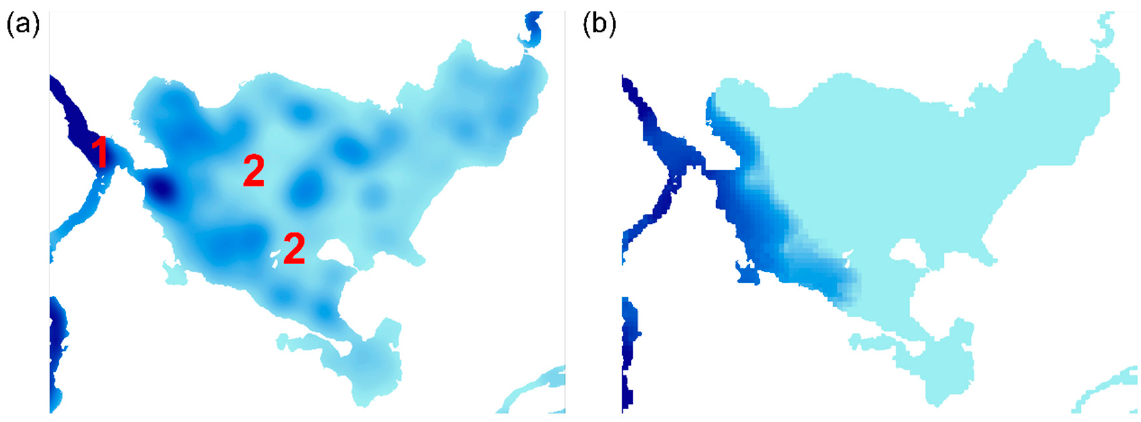
Figure 5. Internal diversity of boat density within Ś niardwy lake: ( a ) based on map derived from Sentinel-1 images and ( b ) based on map derived from field observations. 1—main sailing trail, 2— stone reefs.